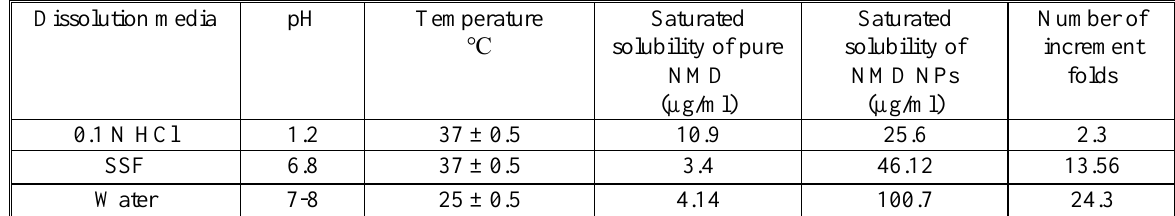
Table 4, The Saturation Solubility of NMD Nanoparticles in Different Dissolution Media